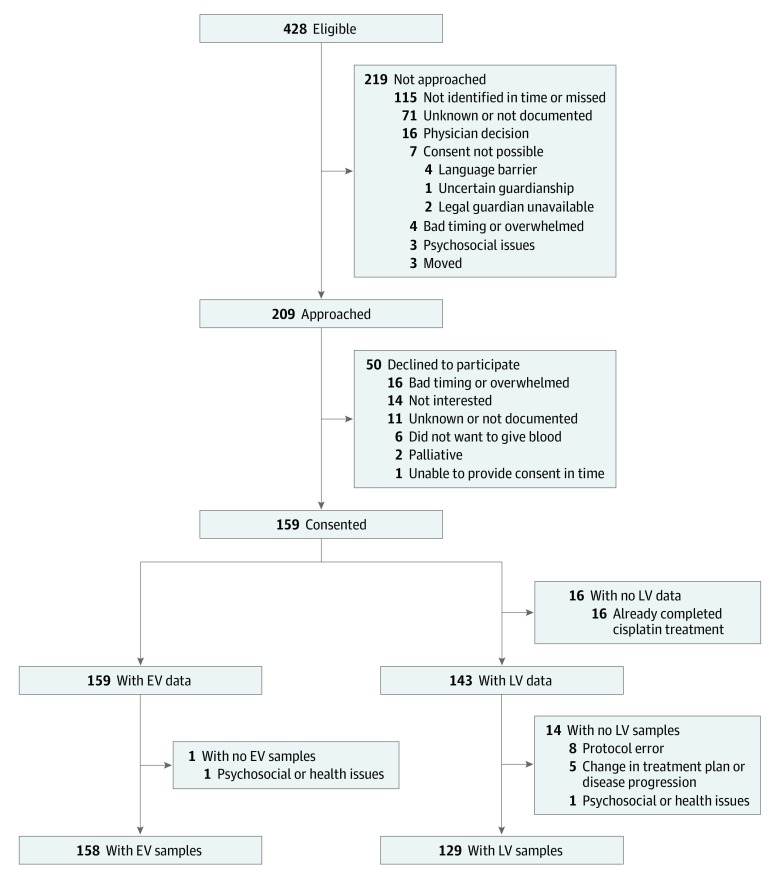
Flow Diagram of Study Participation and Data and Specimen Collection at Early and Late Cisplatin Study VisitsThe study flow diagram outlines the number of patients identified, recruited, and with available data and specimens at each cisplatin study visit (early visit [EV] and late visit [LV]). The top box (number eligible) refers to patients receiving cisplatin during the study activation period (at 6 sites, total number of patients receiving cisplatin may not be completely accurate). A total of 158 study participants had EV samples collected (blood or urine). A total of 129 study participants had LV blood or urine samples collected.